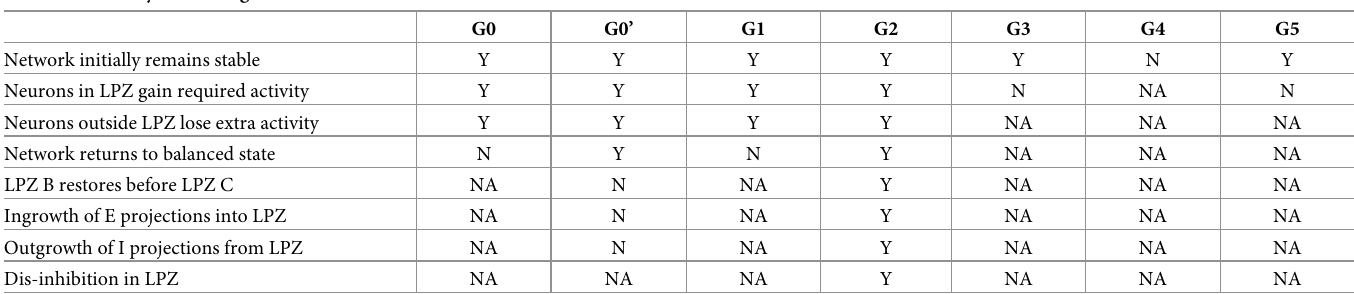
Table 2. Summary of axonal growth curves tested in the model.